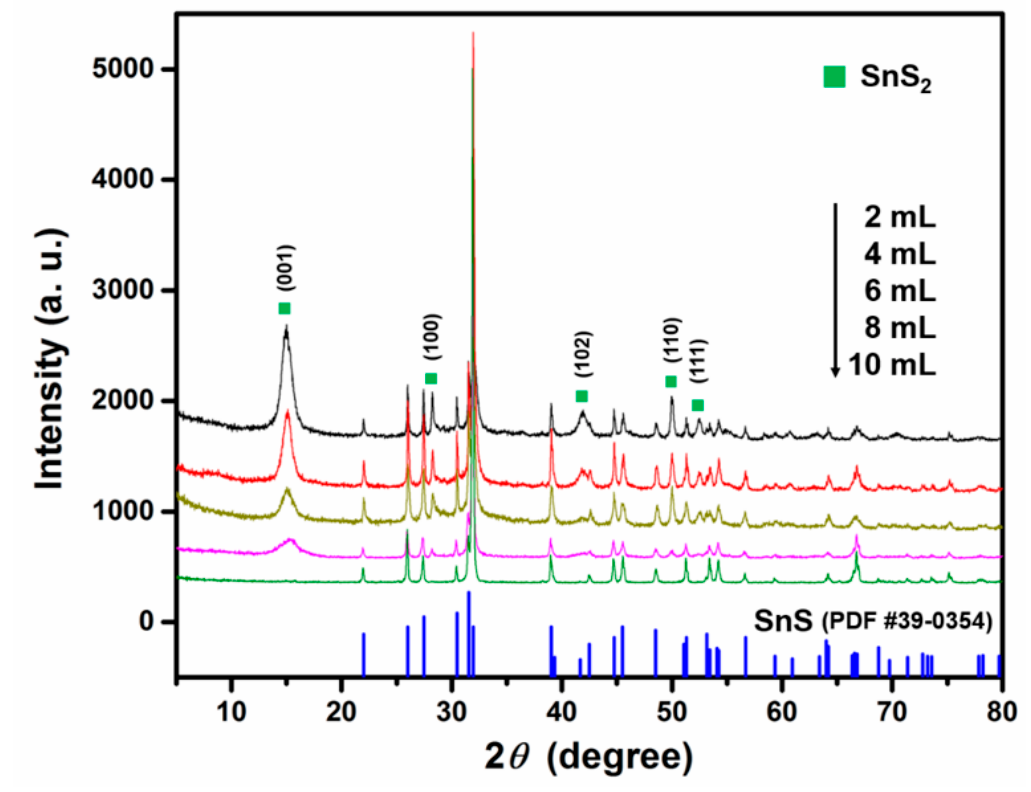
ff erent volumes of